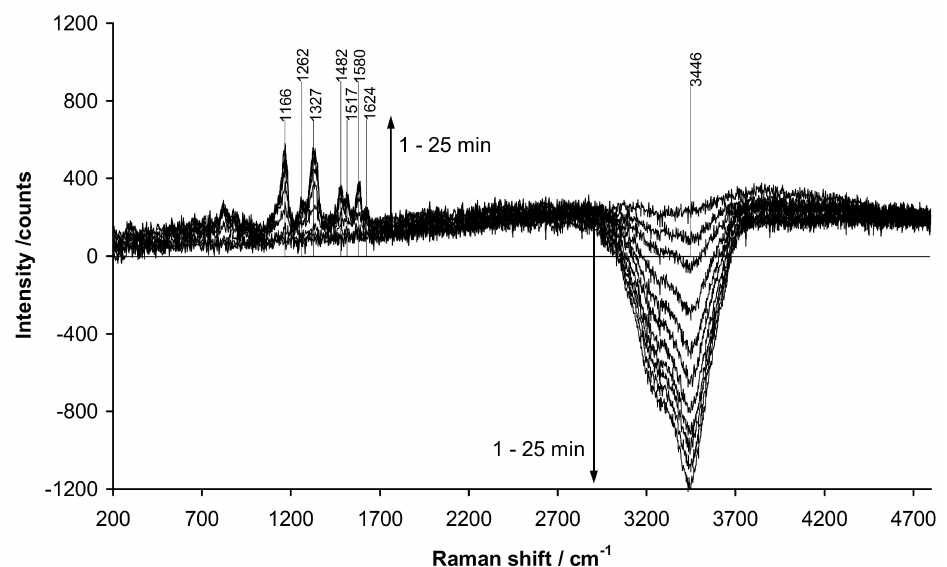
Figure 6. Evolution of Raman spectra (532 nm excitation) of Pt-electrode during galvanostatic elec- tropolymerization of aniline in aqueous solutions of 0.1 M aniline in 0.5 M H 2 SO 4 . Reprinted from Journal of Electroanalytical Chemistry Volume 873, A.A. Nekrasov et al., “Raman spectroelectrochem- ical monitoring of conducting polymer electrosynthesis on reflective metallic electrode: Effects due to double excitation of the electrode/film/solution interfaces”, Pages No. 114415 (1-12), Copyright 2020, with permission from Elsevier